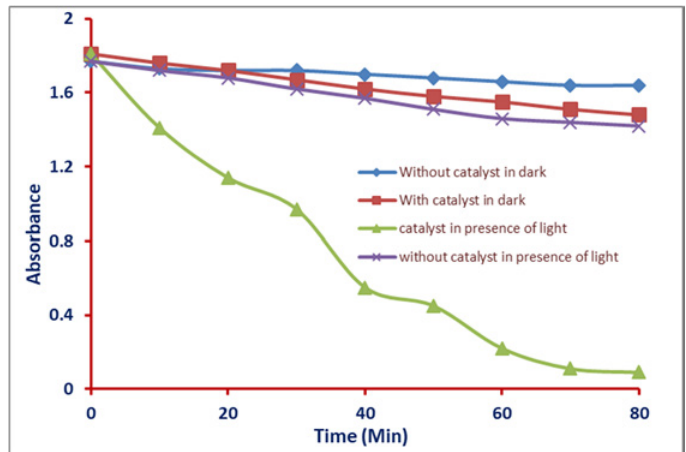
Fig. 5. Effect of catalyst and light irradiation on dye degradation.